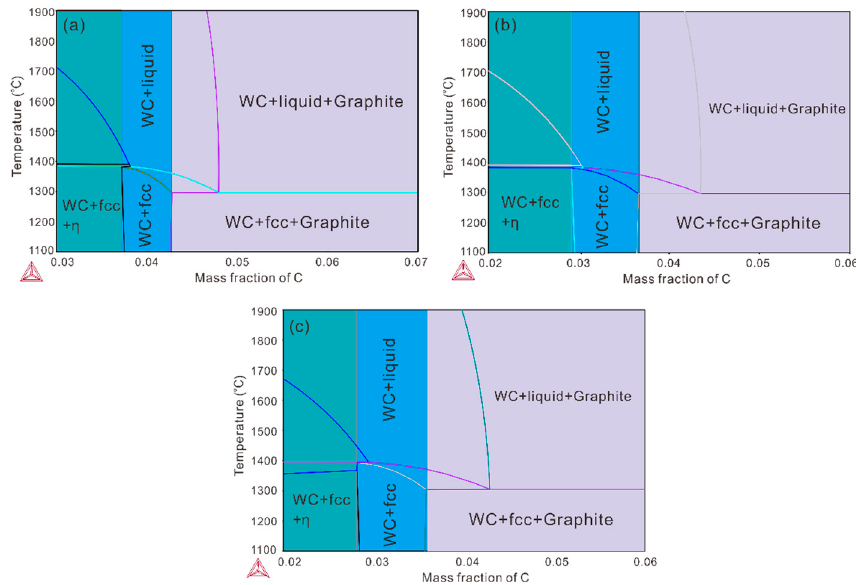
Figure 2. Evaluated phase diagrams by Thermo-calc software: ( a ) WC-30 wt.% (Co, Ni) (Co:Ni = 1:1);